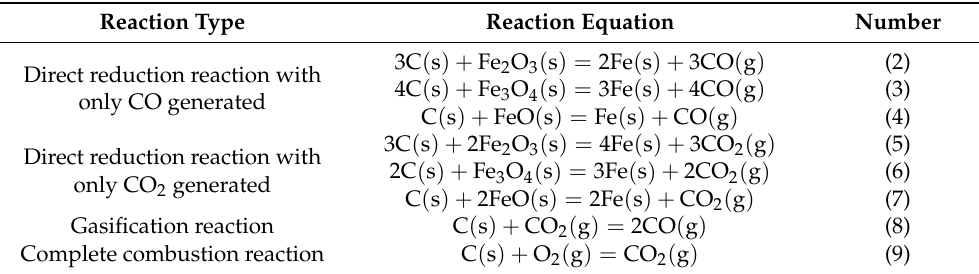
Table 1. The possible chemical reactions between the initial state and the final